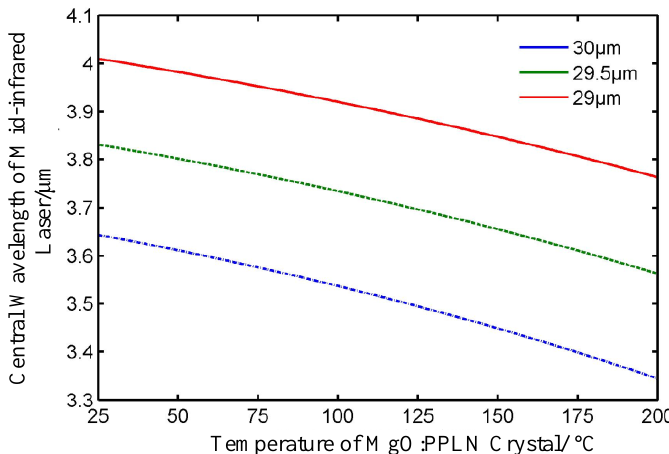
Figure 2. The variation in the curve of the laser wavelength with changes in the temperature of the crystal at different polarization periods.